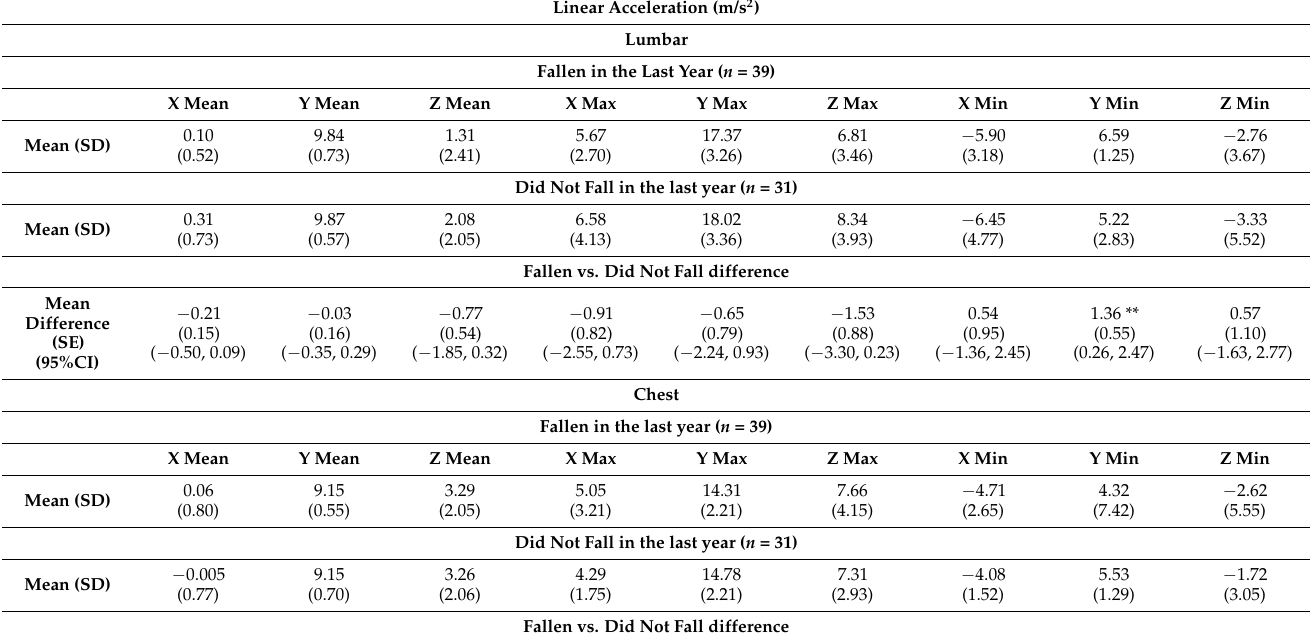
Table 7. Kinematic outcomes differences in the three dimensions between patients who had fallen in the last year and those who did not fall in the last year in the 6MWT. Linear Acceleration (m/s 2 ) Lumbar Fallen in the Last Year ( n =